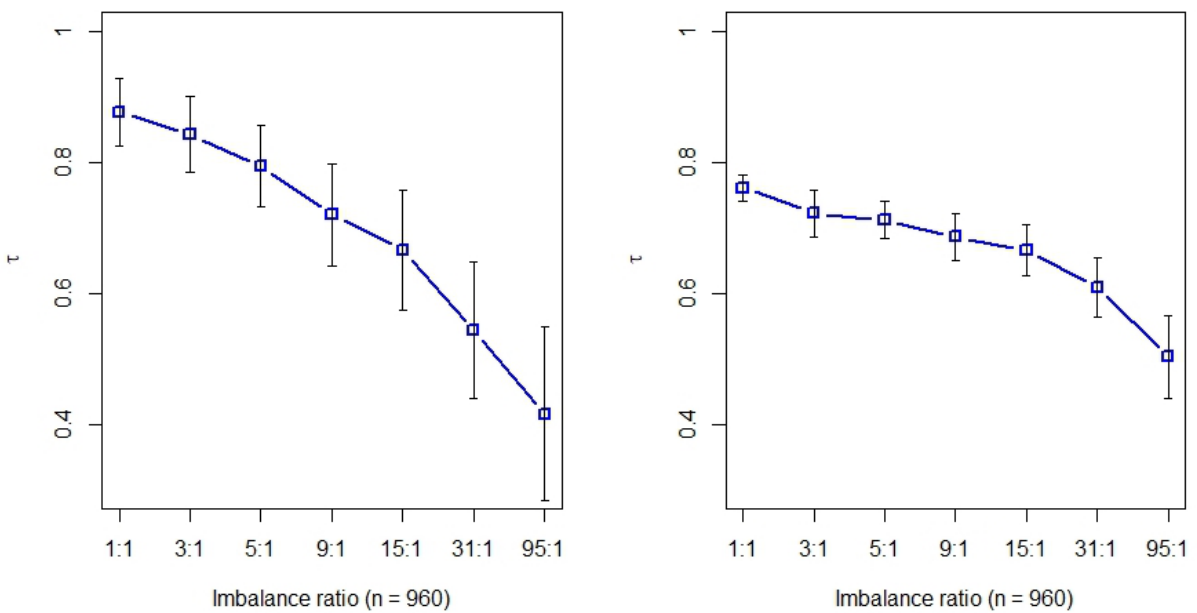
Figure 1. Kendall’s τ rank correlation coefficient under different imbalance ratios (with 100 repeats). Left : eight key variables; right : eight key plus eight irrelevant